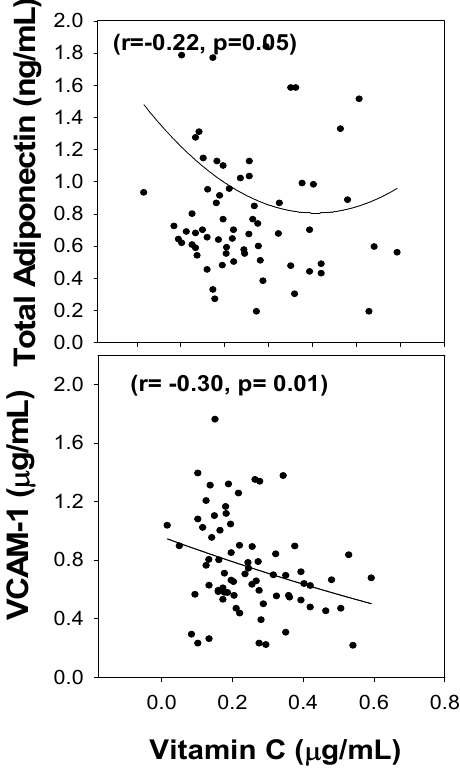
Figure 4. The association of total adiponectin and VCAM-1 with vitamin C blood levels in subjects